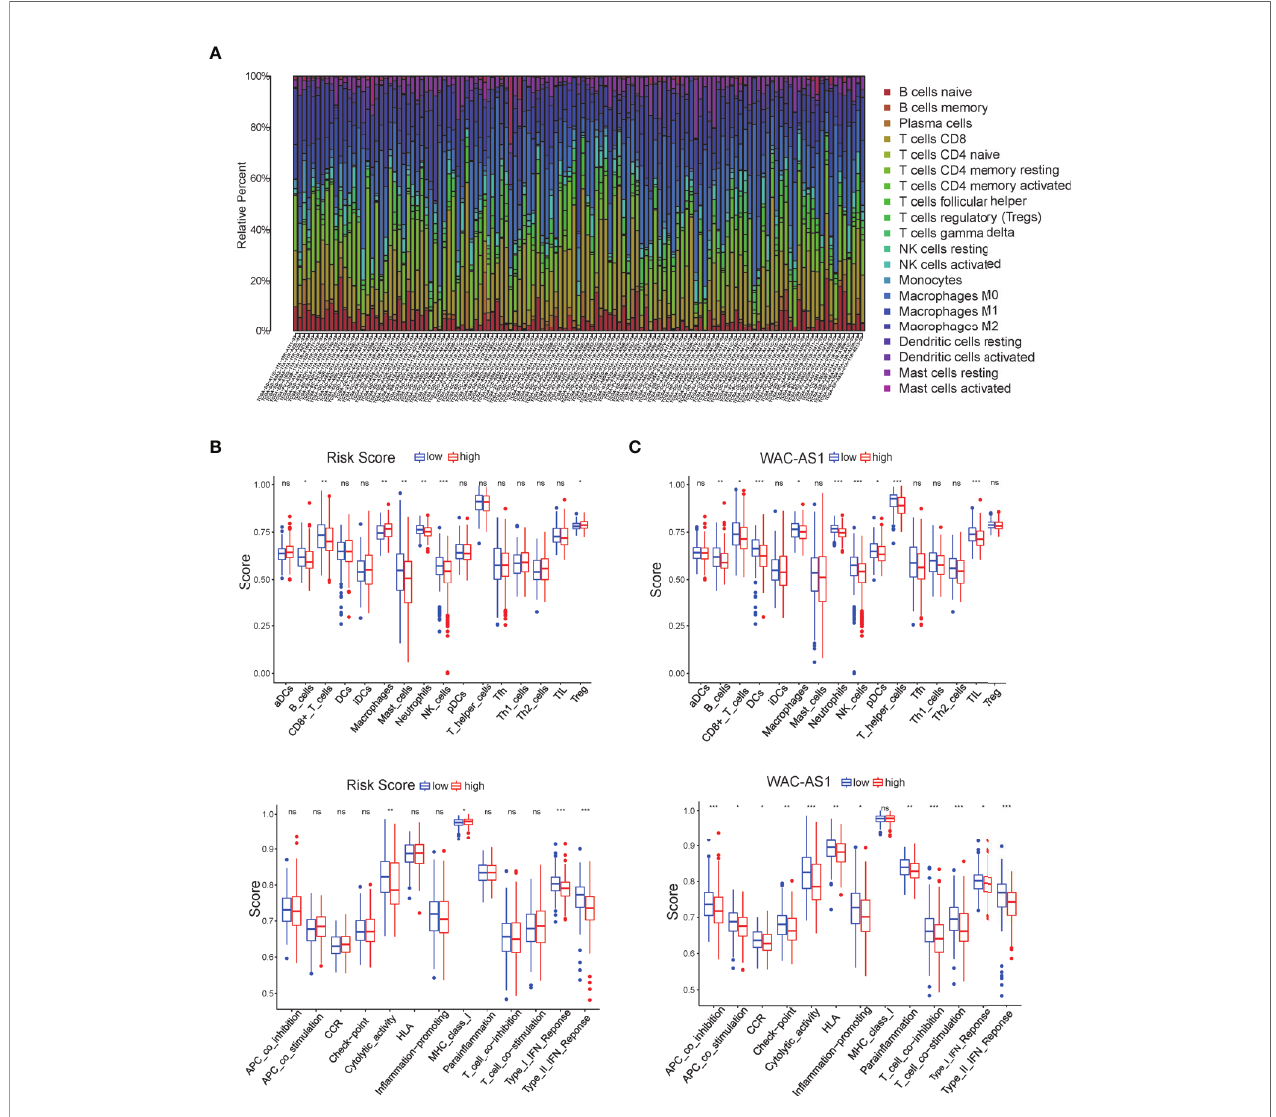
FIGURE 4 | Characterization of immune cell in fi ltration and immune-related functions. (A) Bar chart of the proportions for 22 immune cell types; (B) relationship of the risk score with immune cell in fi ltration and the immune response; (C) relationship of WAC-AS1 with immune cell in fi ltration and the immune response. ∗ P < 0.05, ∗∗ P < 0.01, ***p < 0.001; ns, no signi fi